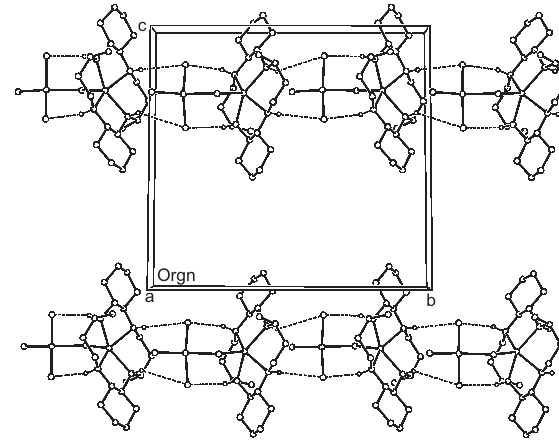
Figure 2 A packing diagram of [Cd II (L)( µ -Cl)Cd II Cl The hydrogen bonds are shown as dashed lines.